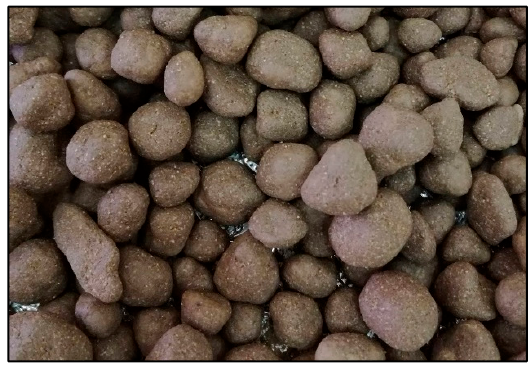
Figure 5. PCM impregnated LECA with geo-polymer coating.